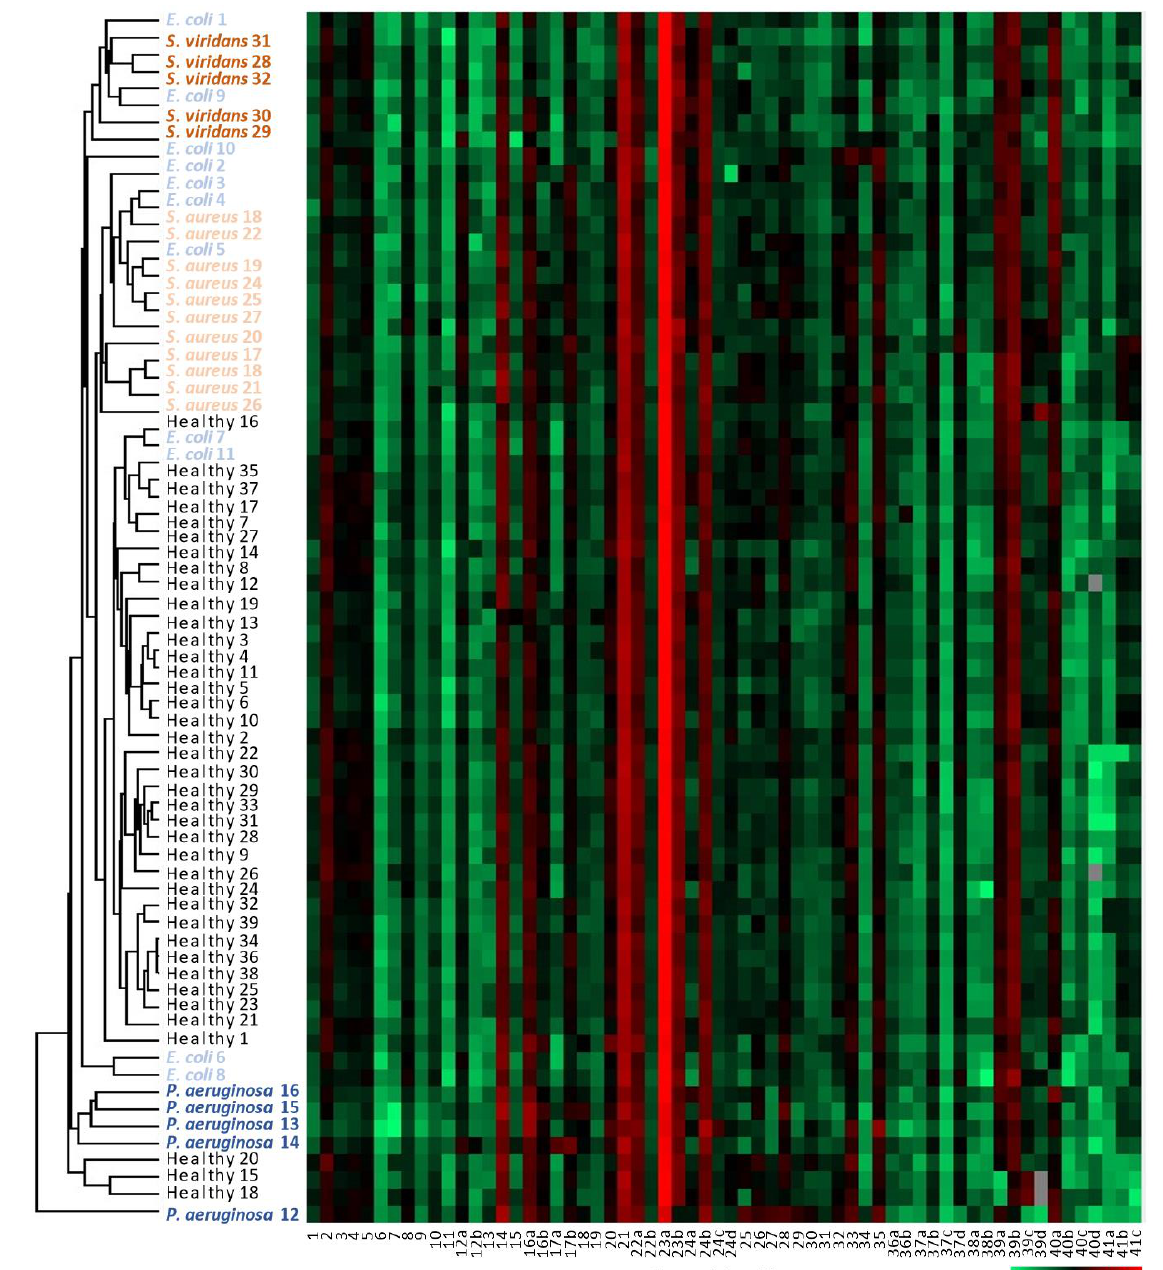
Figure 3. The serum N -glycome separates the bacteremic patient groups and healthy donors. Unsupervised hierarchical cluster analysis using Euclidean distance and average linkage ( left ) and heat-map representation of the N -glycome profiling data ( right ) performed using the Perseus software after log2 transformation of the relative abundances of the 62 N -glycan structures (glycan identifier 1-41c) identified and quantified across all 71 samples investigated in this study. Some very low abundant glycan isomers were not detected in a few samples (indicated as grey pixels in the heat-map), due to minor technical variations between the individual MS/MS runs and/or due to the inherent biological variation within each patient group. See Supplementary Table S2 for details of the quantitative glycome data. See Figure 2 for structures and glycan identifiers. See Supplementary Table S1 for metadata and patient identifiers. See Supplementary Data S1–S3 for spectral